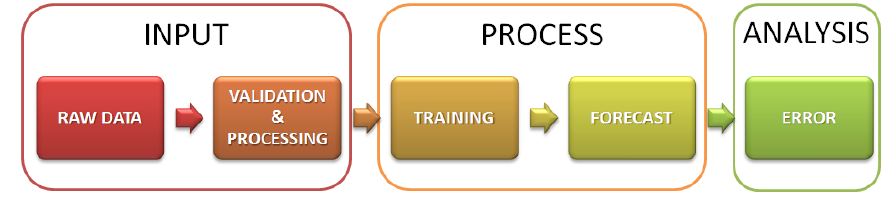
Figure 1. Forecasting flow